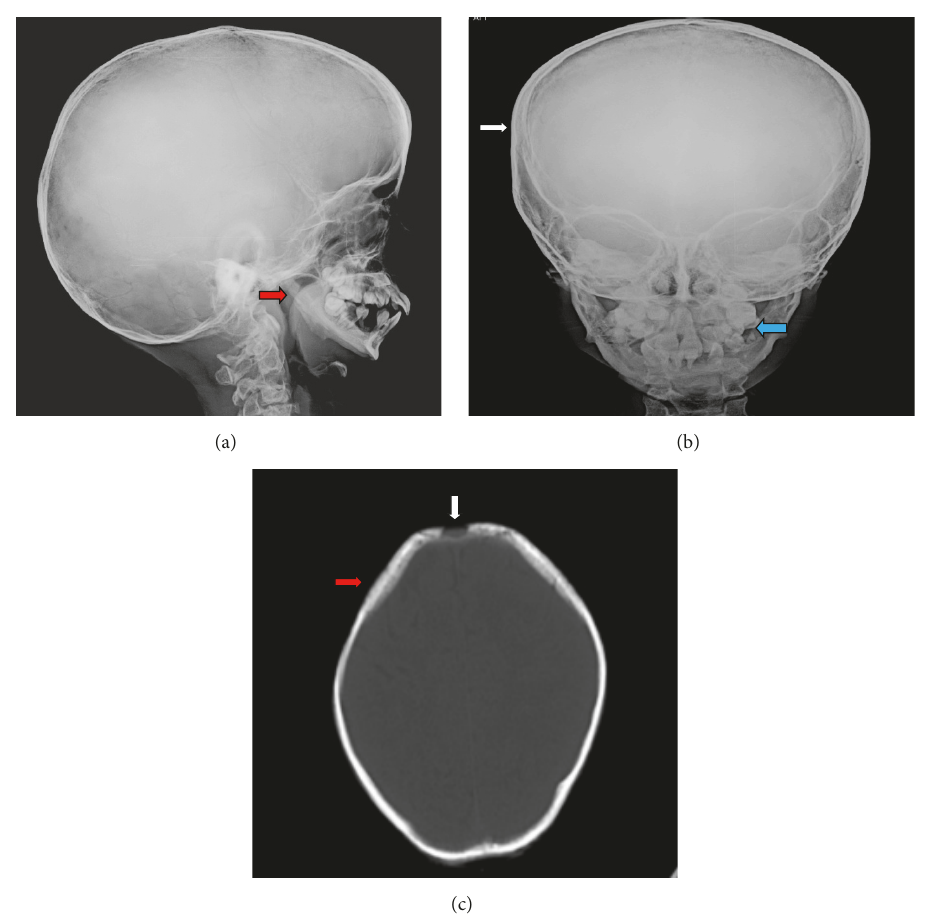
Figure 2: Skull radiograph lateral and anteroposterior views (a, b) showing disproportionate large calvarium with hypoplastic facial bones, small mandible with small ascending ramus, and obtuse mandibular angle (red arrow) and overcrowding of teeth (blue arrow). CT head (c) showing open anterior fontanelle (white arrow) and large cranial vault with thin diploic space (red